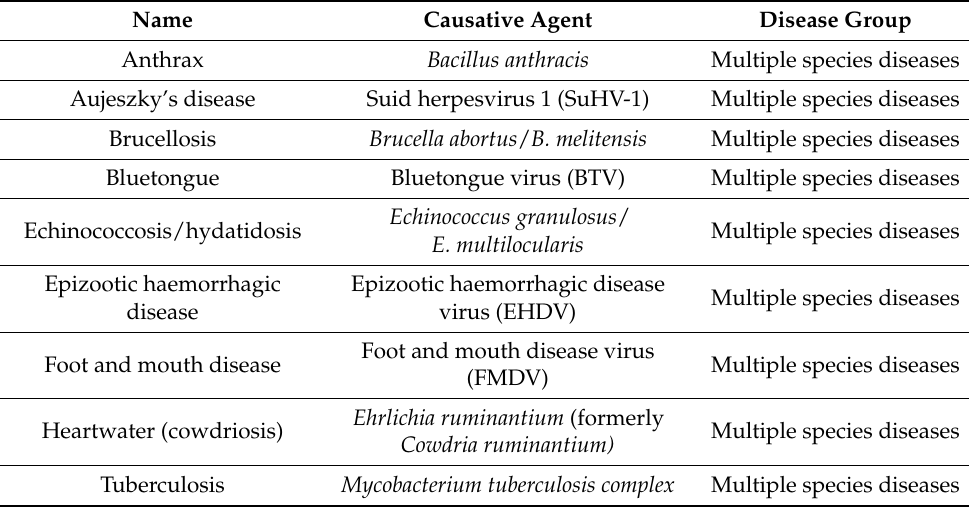
Table A1. OIE listed diseases for which vaccines have been developed